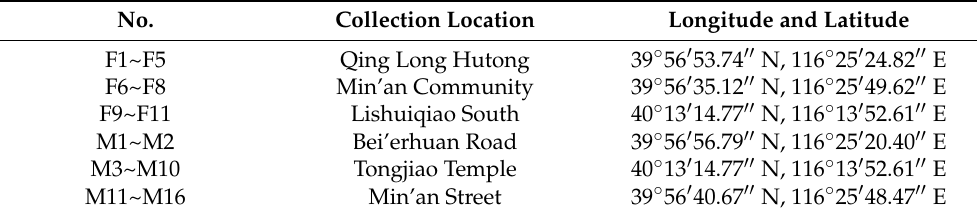
Table 2. Collection locations of samples in Beijing,